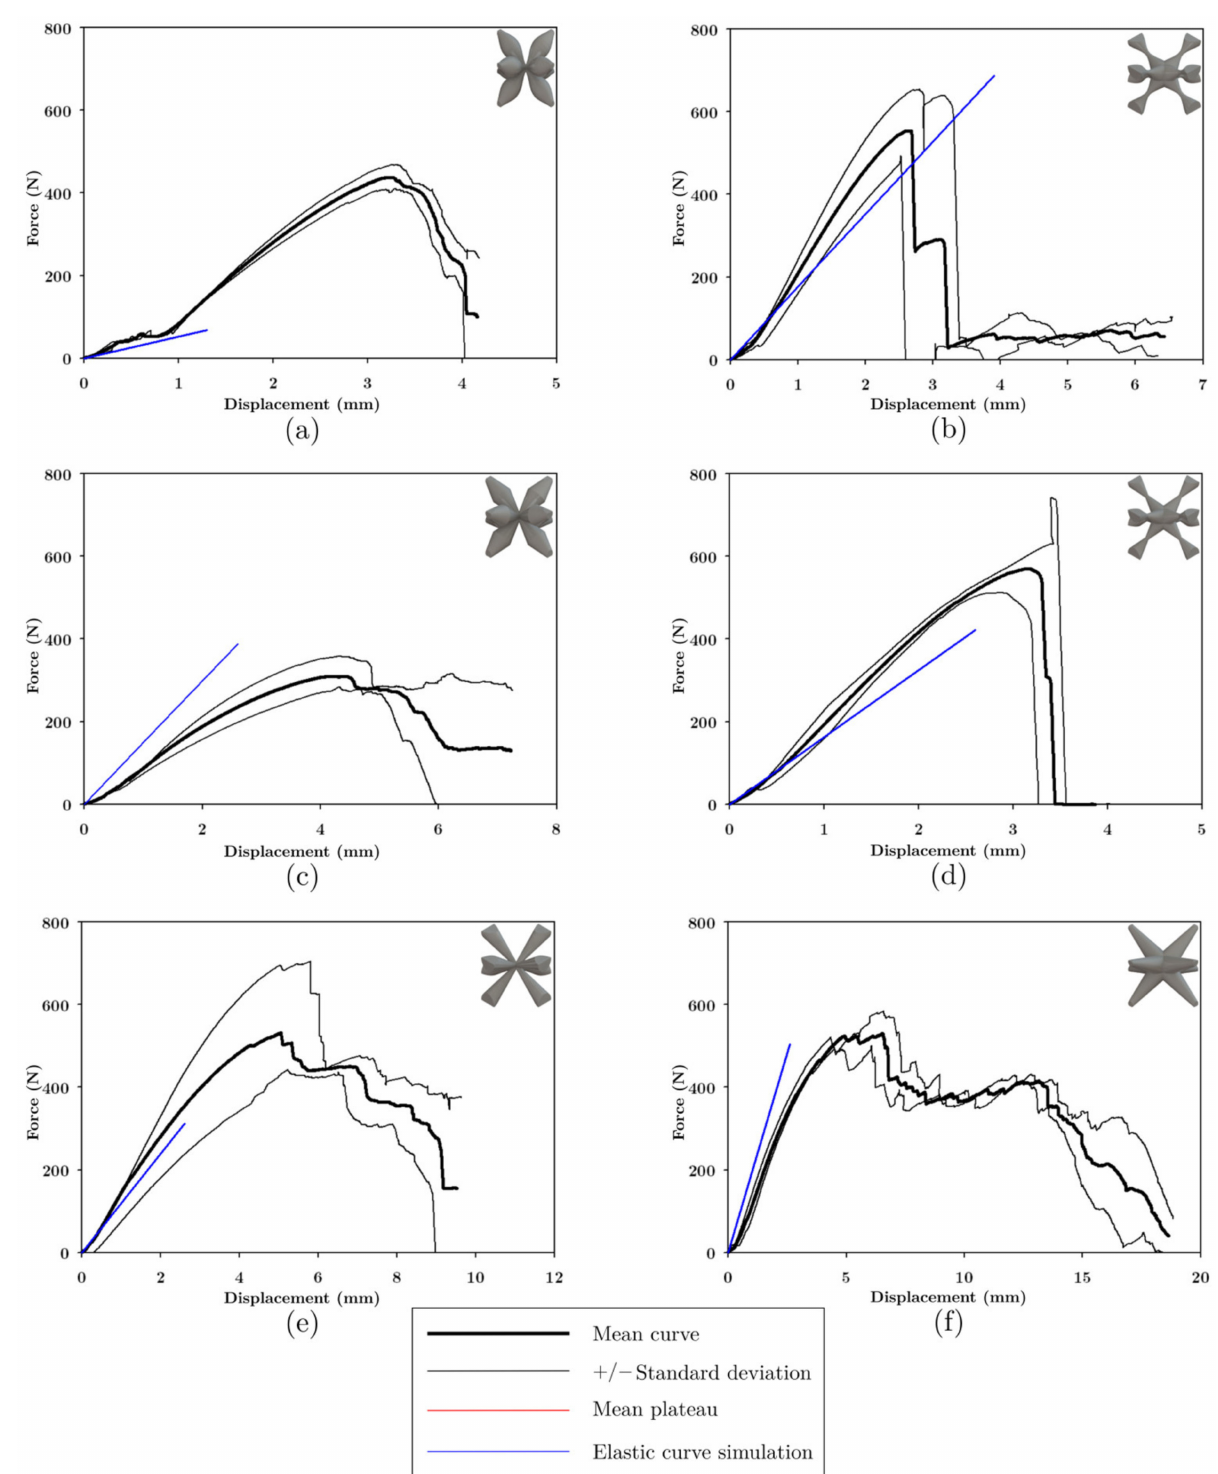
Figure 18. Force-displacement curve of UPLS manufactured with resin. For each variation in strut cross-section ( a ) COS, ( b ) COS2, ( c ) DS, ( d ) DIS, ( e ) PS, and ( f )